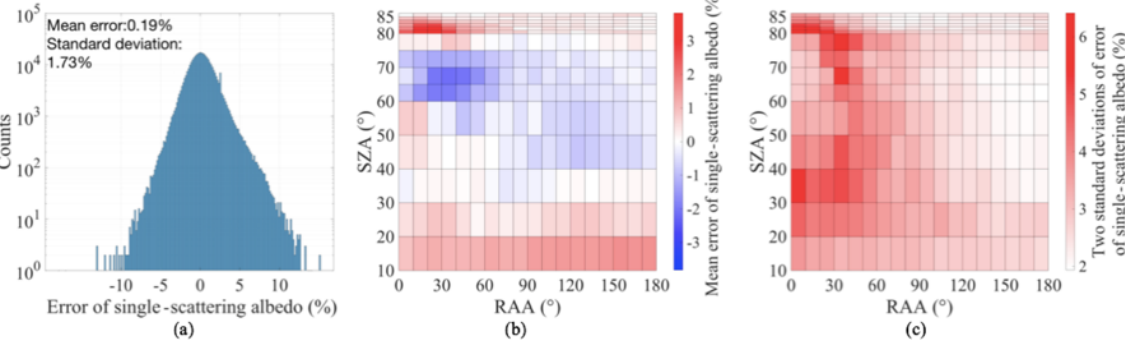
Figure 9. Single-scattering albedo retrieval errors: (a) error histogram, (b) mean error as a function of SZA and RAA, and (c) 2 standard deviations as a function of SZA and RAA.